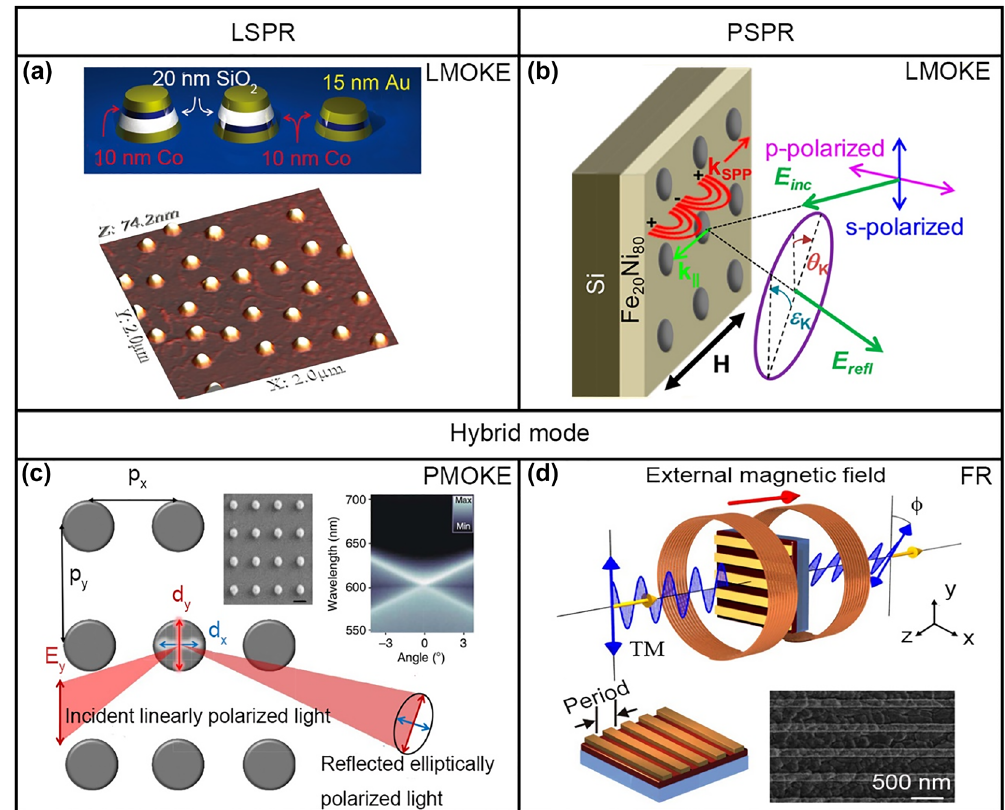
Figure 2: Resonance modes reported in magnetoplasmonics